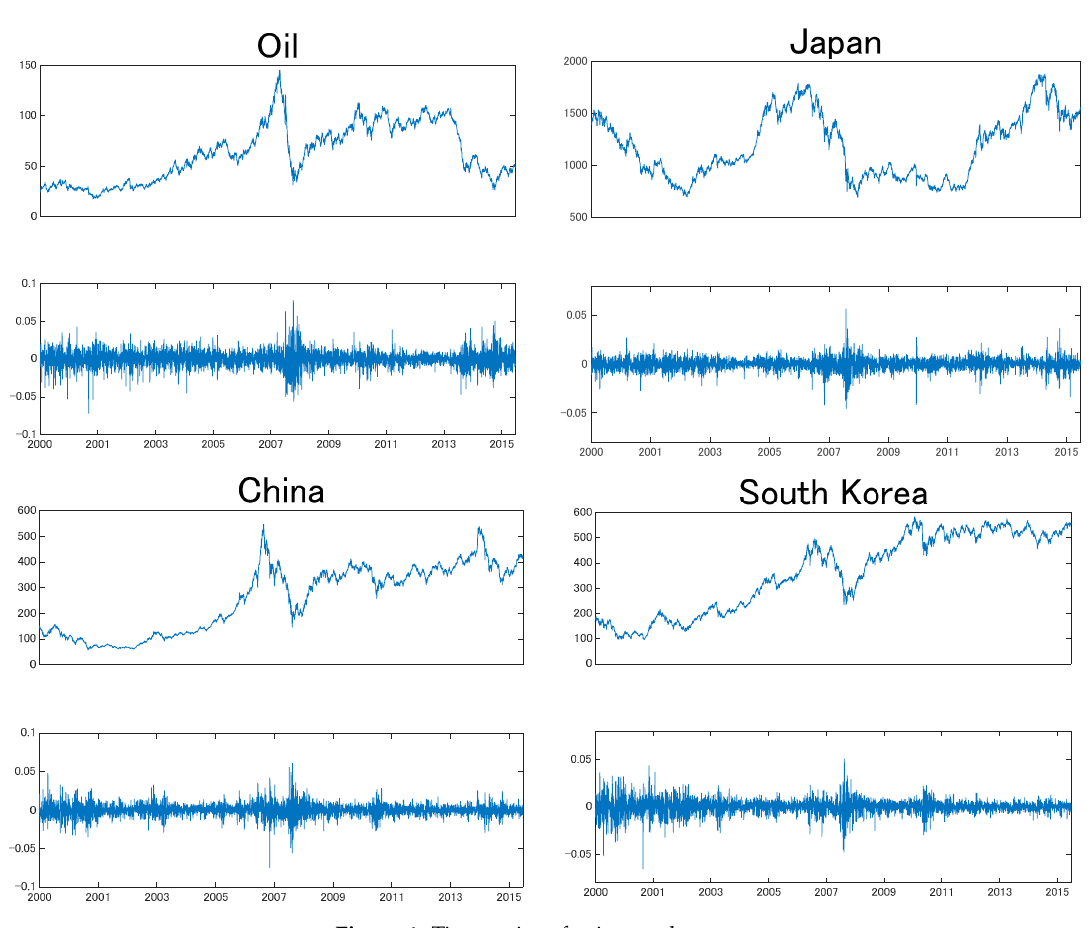
Figure 1. Time series of prices and returns.